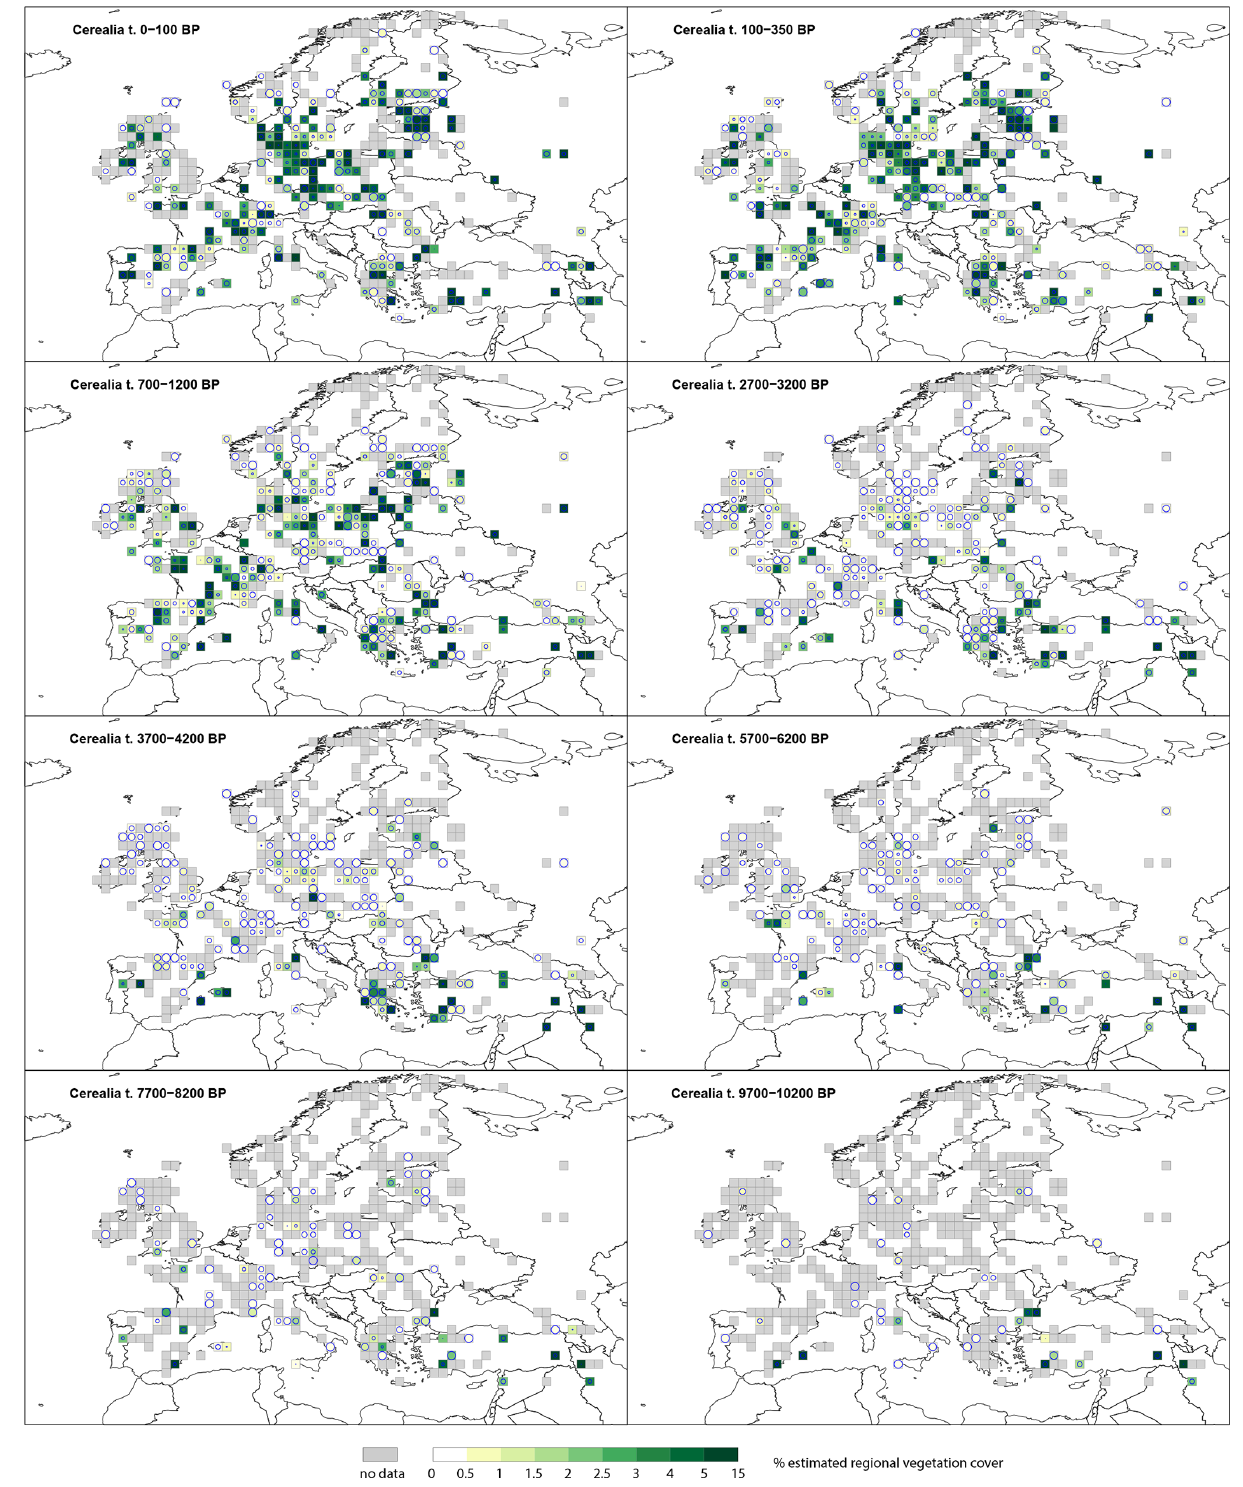
Figure 5. Grid-based REVEALS estimates of Cerealia t. cover for eight Holocene time windows. Percentage cover in 0.5% intervals between 0% and 3%, 1% intervals between 3% and 5%, and 5% intervals between 5% and 10%. Intervals represented by increasingly darker shades of green from 1%–1.5%. Grey cells: cells without pollen data for the time window but with pollen data in other time windows. Circles in grid cells represent the coefficient of variation (CV; the standard error divided by the REVEALS estimate). When SE ≥ REVEALS estimate, the circle fills the entire grid cell, and the REVEALS estimate is not different from zero. This occurs mainly where REVEALS estimates are